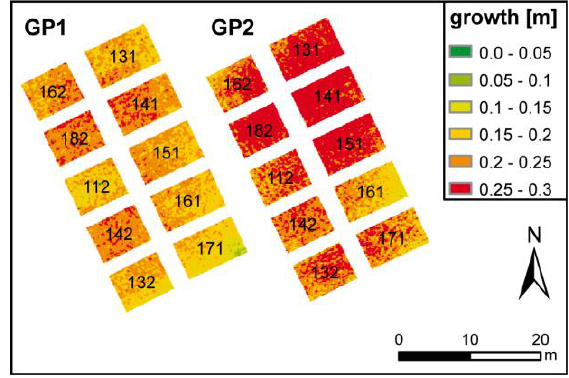
Figure 7. Plant growth of selected plots in flight strip 3 ( selection b ) for GP1 and GP2 (Esri